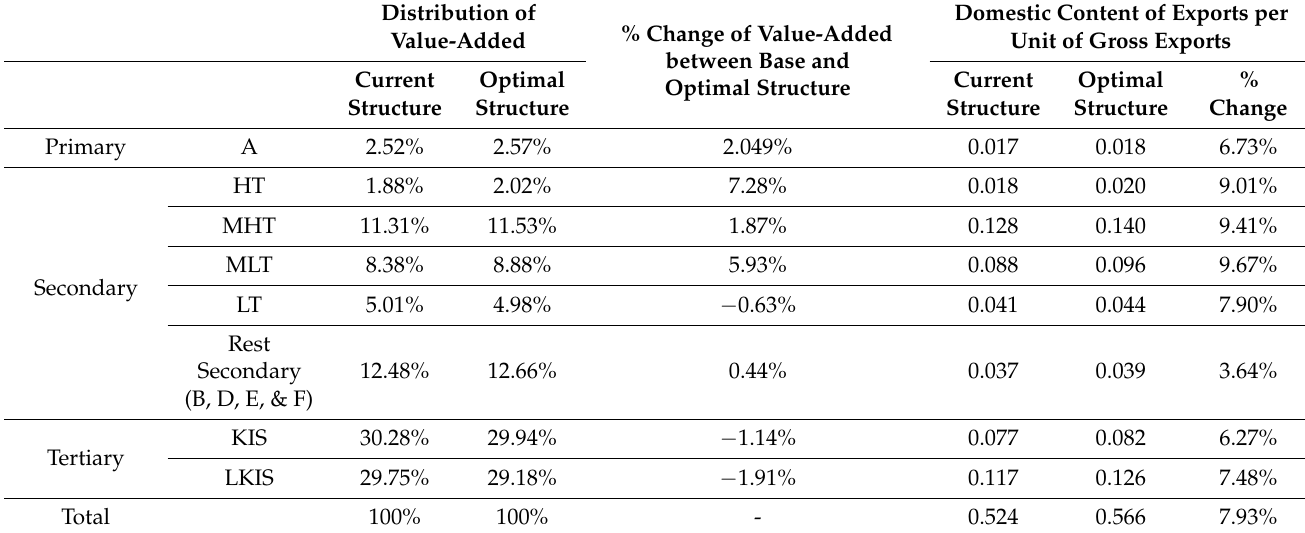
Table 2. Impact of restructuring in the basic economic measures of the Czech Economy. Distribution of Value-Added % Change of Value-Added between Base and Optimal Optimal Structure Structure Structure